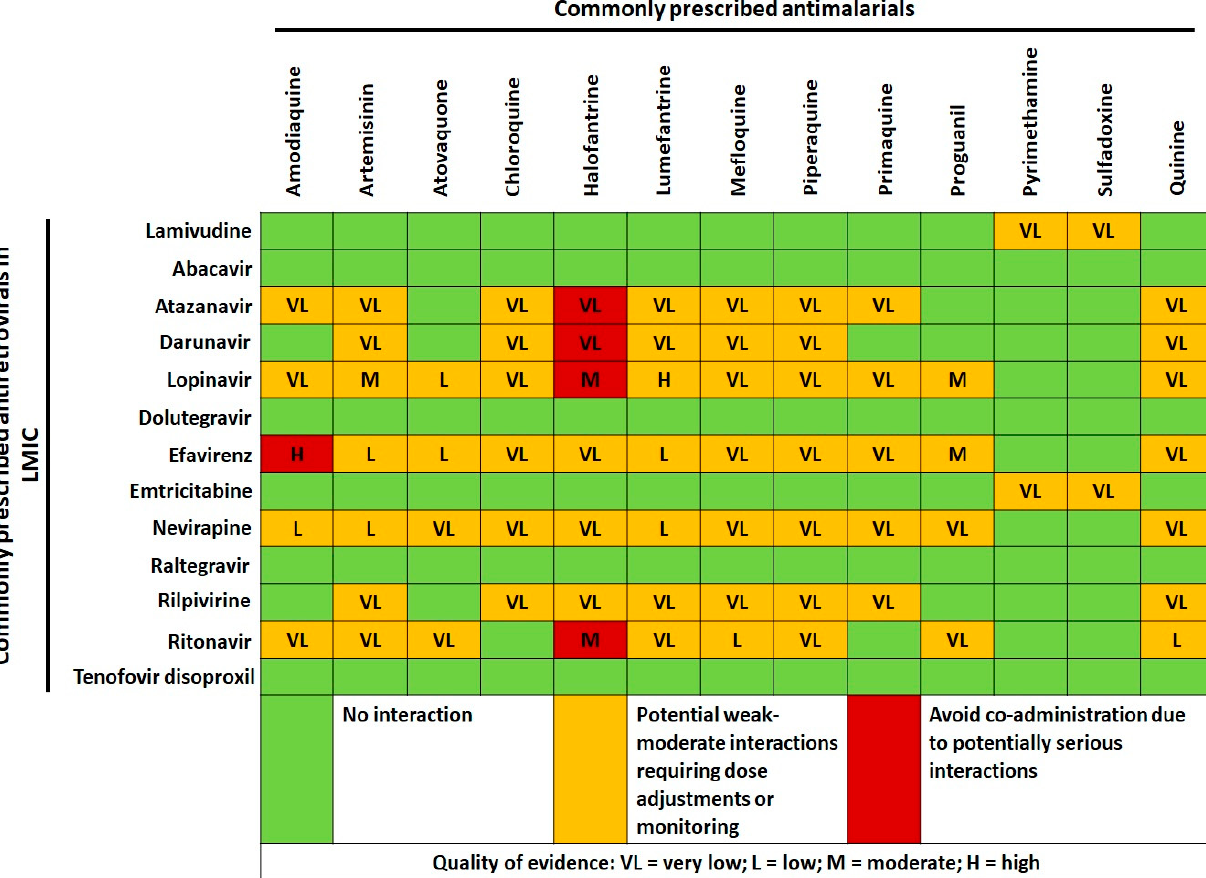
Figure 2. Cross-tabulation of drug–drug interactions between commonly prescribed antimalarials and antiretrovirals in low and middle-income countries (LMIC). Data and quality of scientific evidence were extrapolated from the HIV Drug interaction checker online tool, University of Liverpool (https://www.hiv-druginteractions.org/checker; last access date 20 July 2021).